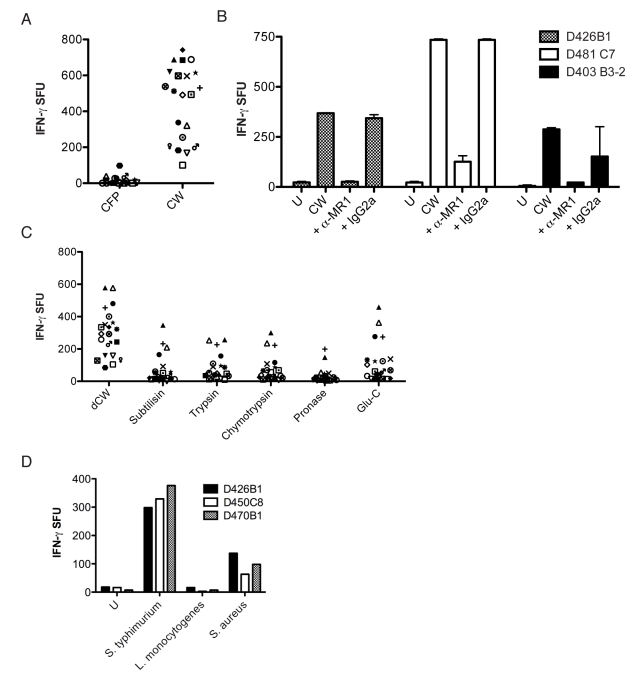
MR1 presents a protein-containing antigen from the mycobacterial cell wall.(A) CFP or CW from the Mtb strain H37Rv were added (5 µg/ml) to DCs (25,000/well) for 1 h prior to the addition of one of 21 NC clones (5,000/well) followed by IFN-γ ELISPOT assay. (B) DCs (25,000) loaded with CW overnight were incubated with anti-MR1 blocking antibody (clone 26.5) or a mouse IgG2a isotype control (both at 5 µg/ml) for 1 h prior to the addition of T-cell clones (10,000/well). (C) dCW from Mtb was treated with proteases (subtilisin, trypsin, chymotrypsin, pronase, Glu-C) and added (5 µg/ml) to DCs (25,000/well) for 1 h before the addition of 21 NC clones (5,000/well) that were tested for their ability to produce IFN-γ in an ELISPOT assay. Reversed phase- high performance liquid chromatography (RP-HPLC) chromatogram analyses were used to confirm the inactivation of proteases. No responses were detected in the absence of DCs. (D) DCs were infected with S. typhimurium, L. monocytogenes, and S. aureus for 1 h with a calculated moi of 145, 6, and 15, respectively. DCs were washed, antibiotics added, and DCs (25,000) were incubated with three different Mtb-reactive MAIT-cell clones (10,000/well) that were tested for their ability to produce IFN-γ in an ELISPOT assay. Results shown are similar to a minimum of three independent experiments where S. typhimurium, L. monocytogenes, and S. aureus were tested at a variety of moi ranging from 5 to 150.